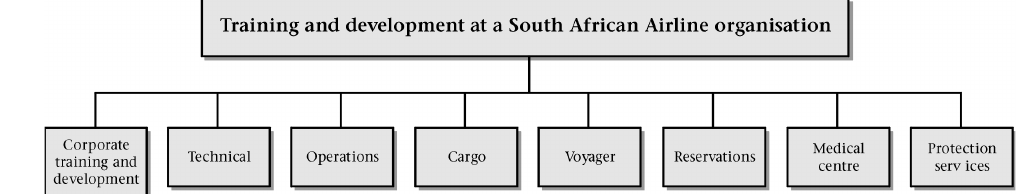
Figure 3: The ‘Training and Learning Academy’